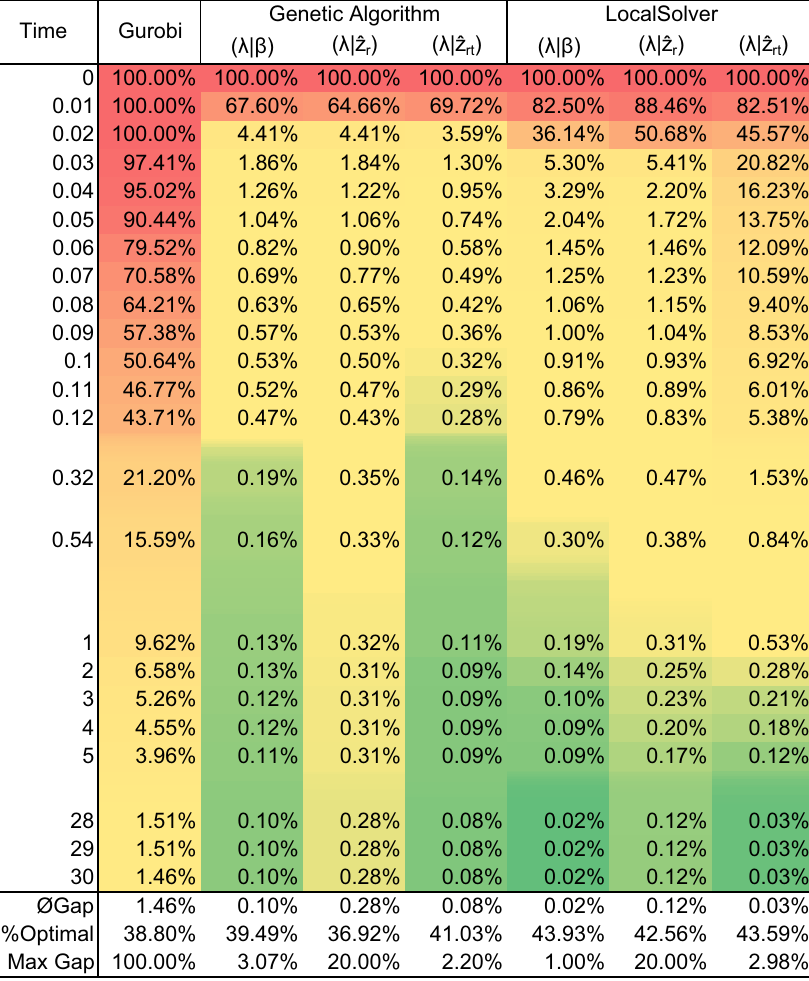
Table 4 Numerical results over time for small projects with 30 non-dummy